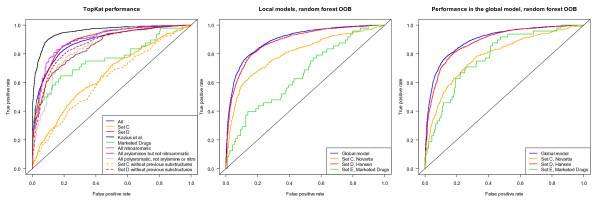
ROC curve performance for models on all-substructure data sets. The left plot shows the performance of the default TopKat Ames mutagenicity model on Sets C (orange), D (red), E (green), and F (black) as well as the performance for particular substructures in all sets (blue): nitroaromatics (purple), aryl-amines (brown), or polyaromatic (gray). Dotted lines for Sets C and D show performance after removing these substructures. The center plot shows the out-of-bag performance of random forest models built on Sets C (orange), D (red), and E (green) and the global model (blue) when they are used as the training set. The right plot shows the Set C, D, or E subsets of the global out-of-bag performance (blue) of a random forest model built on all of the data.